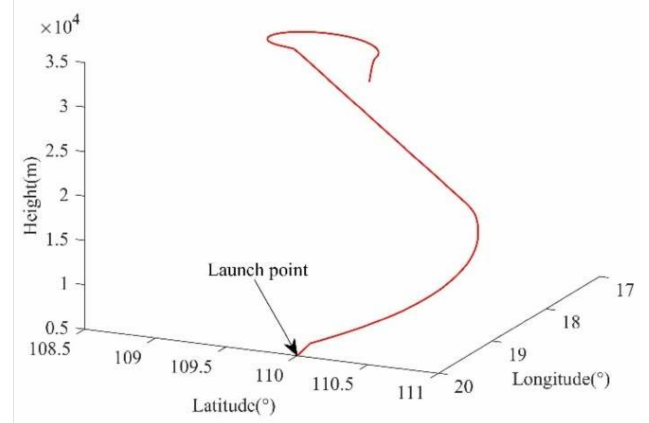
Figure 7. Path of aerospace